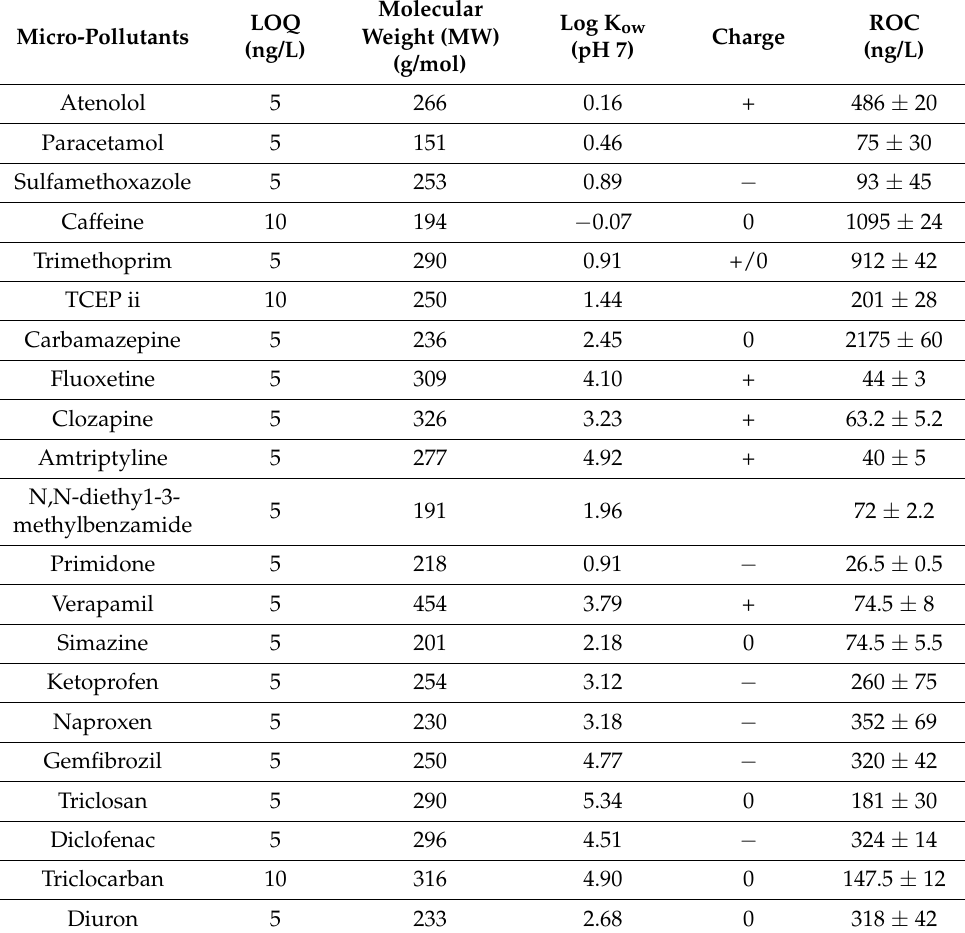
Table 4. Micro-pollutants in the ROC (ng/L)